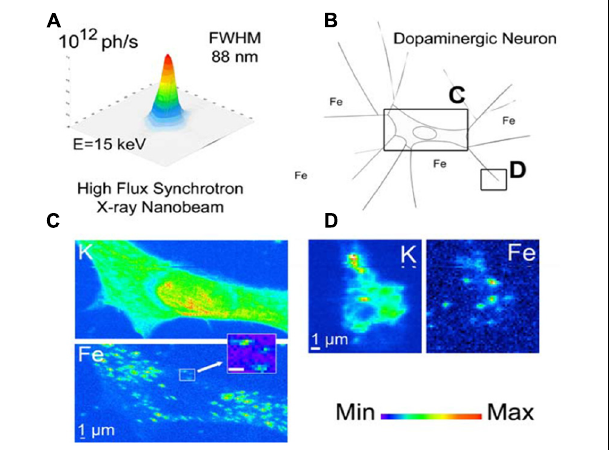
FIGURE 2 | SXRF mapping with hard X-rays at sub-cellular resolution. Dopamine-producing cells are chemically mapped with sub-90 nm beam, revealing potassium and iron distribution. In panel (A) the intensity distribution in the focal plane is shown; panel (B) illustrates the dopamine producing cells exposed in vitro to 300 mM FeSO 4 for 24 h. Chemical element distributions of potassium (K) and iron (Fe) were recorded on distinct cellular areas including cell bodies (C) and distal ends (D) . Iron was found in 200 nm structures in the cytosol, neurite outgrowths, and distal ends, but not in the nucleus. Units for the min-max intensity bar are arbitrary. Scale bars = 1 mm. Adapted from Ortega etal.